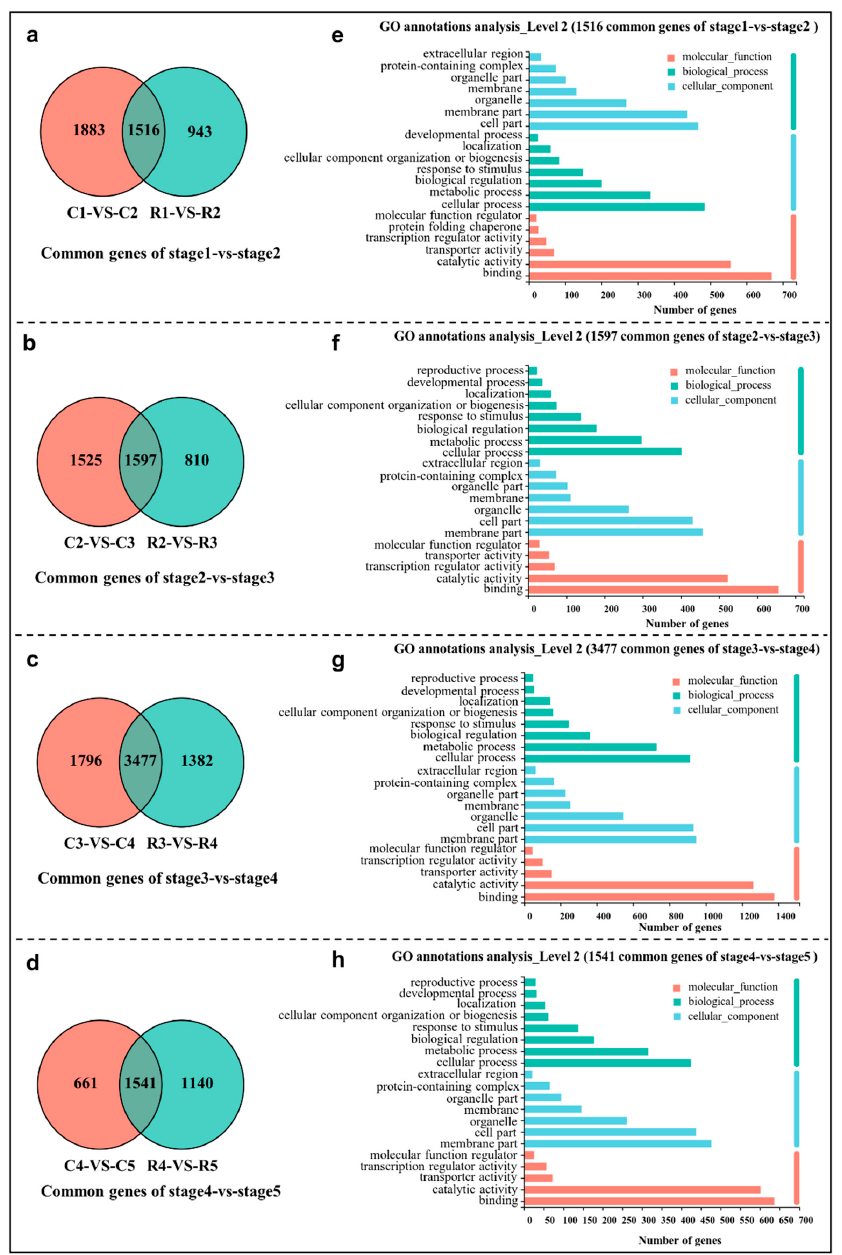
Figure 2. Venn diagram of common DEGs in stage1 vs stage2 ( a ), stage2 vs stage3 ( b ), stage3 vs stage4 ( c ), stage4 vs stage5 ( d ), and GO classification ( e – h ) of these common